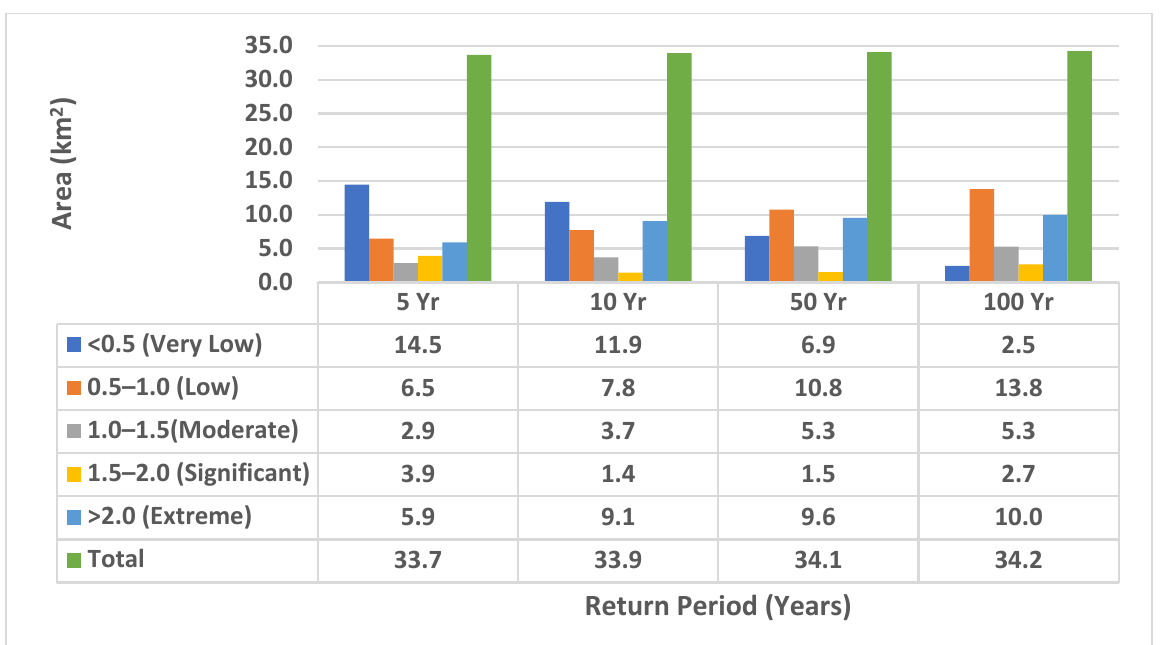
Figure 13. Risk classification of Commercial Farming Land Cover Type.